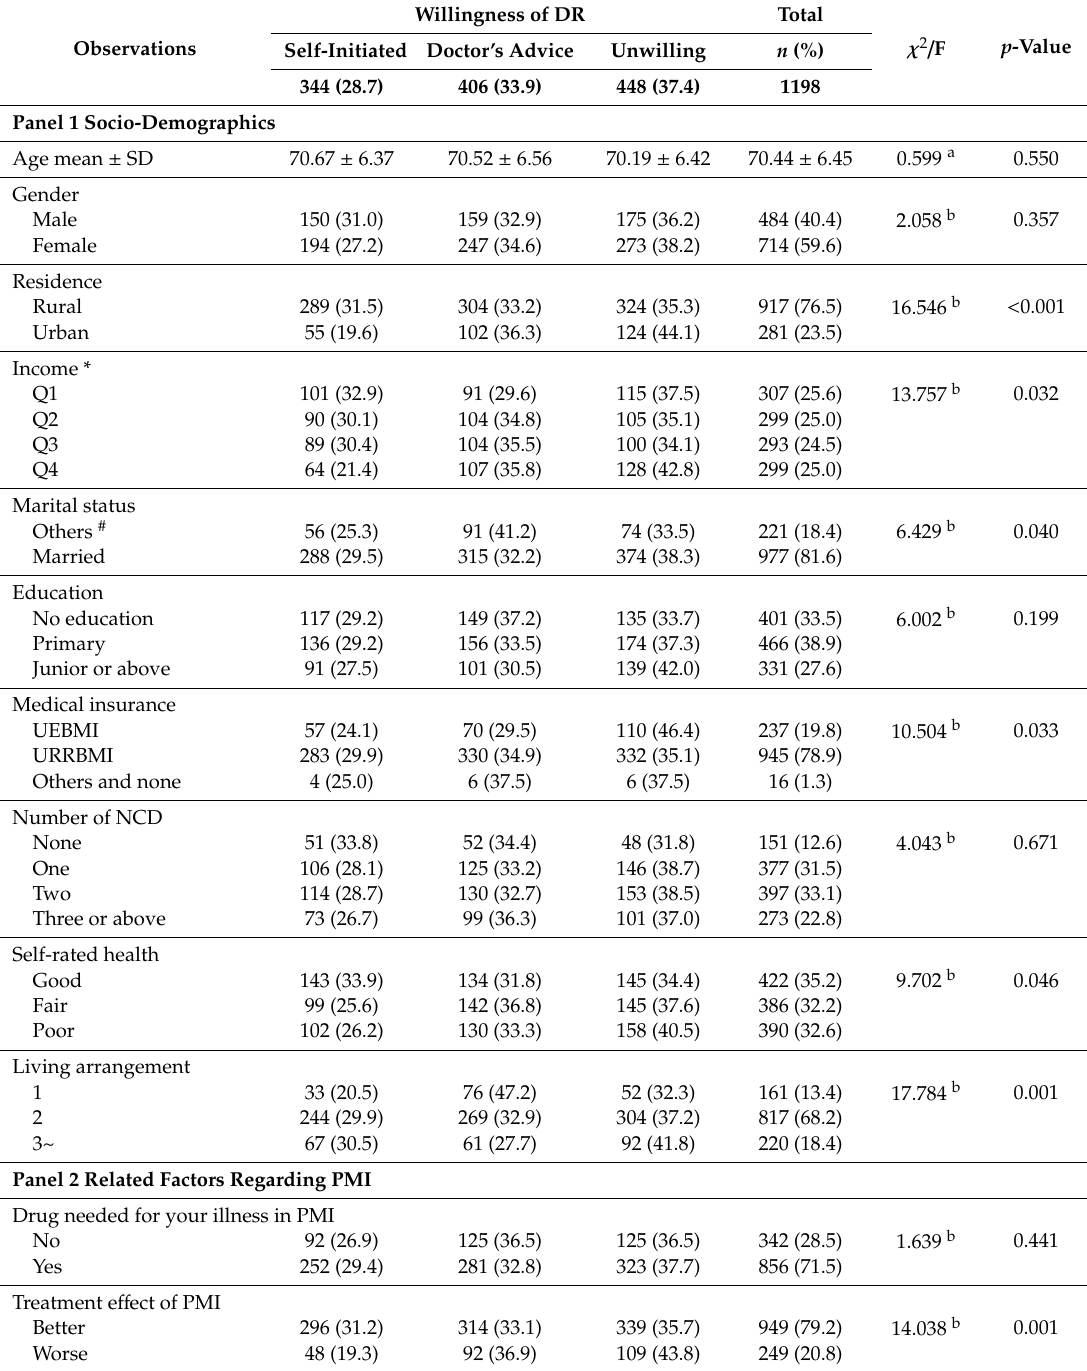
Table 1. Factors associated with older adults’ willingness for downward referral